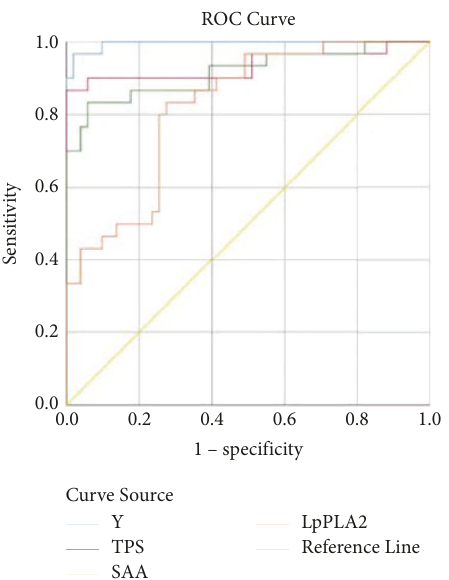
Figure 1: ROC curves for the new variable Y and the three biomarkers.